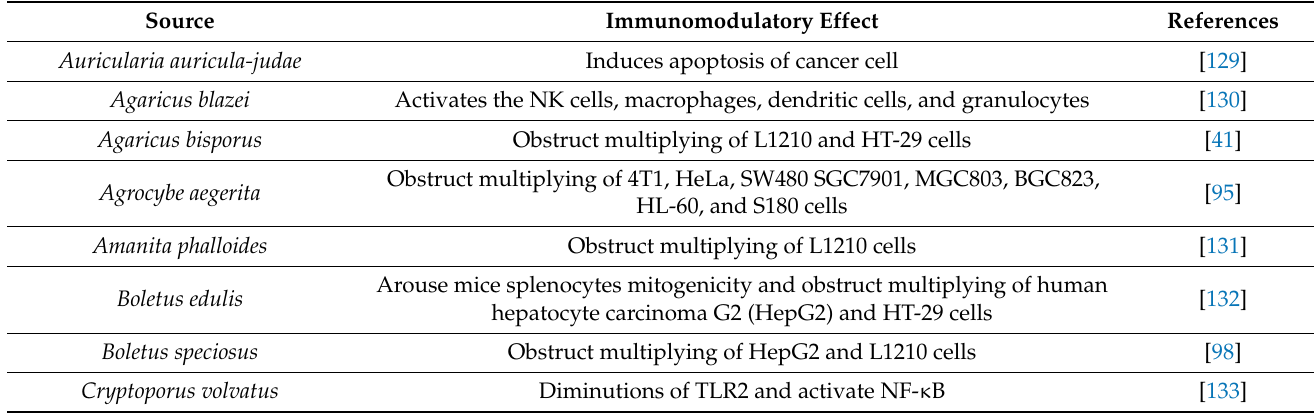
Table 4. Mushrooms having an immunomodulatory